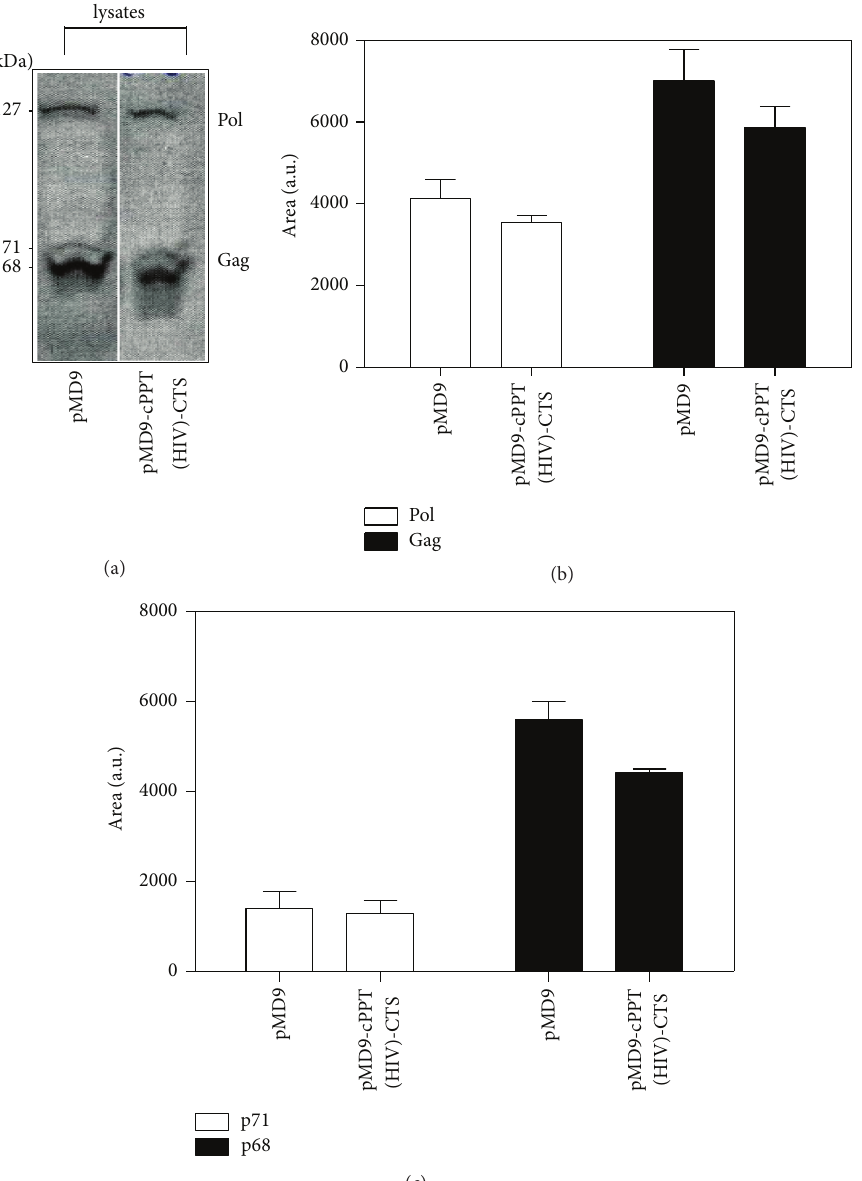
Figure 5: Analysis of pMD9 parental vector and its modification (pMD9-cPPT (HIV)-CTS). Detection of PFV proteins in HEK 293T cells (a) contransfected with the retroviral vectors was measured quantitatively for Gag/Pol (b) and Gag fractions (p71, p68) (c). The mean ± SD values from three independent assays are shown. The area is measured in arbitrary units, which are abbreviated as a.u.